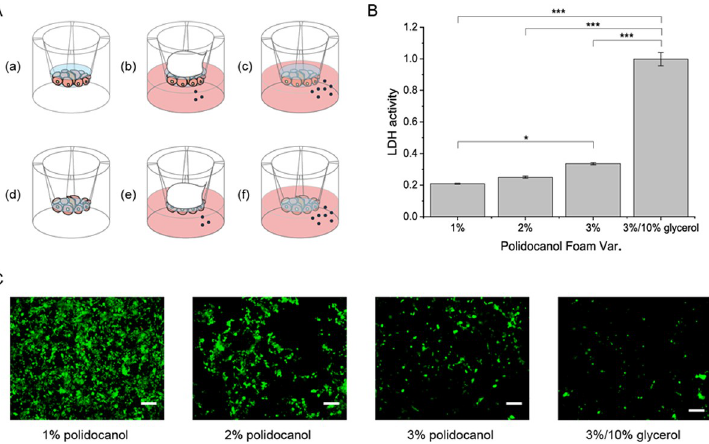
Fig 3. Glycerol in polidocanol foam better destabilizes cell membrane. (A) Scheme for in vitro foam analysis. (B) LDH results. (C) Live and dead image. No red signal is detected from all the cells affected by the foam, which are detached from the transwell membrane. (Scale bar = 100 μ